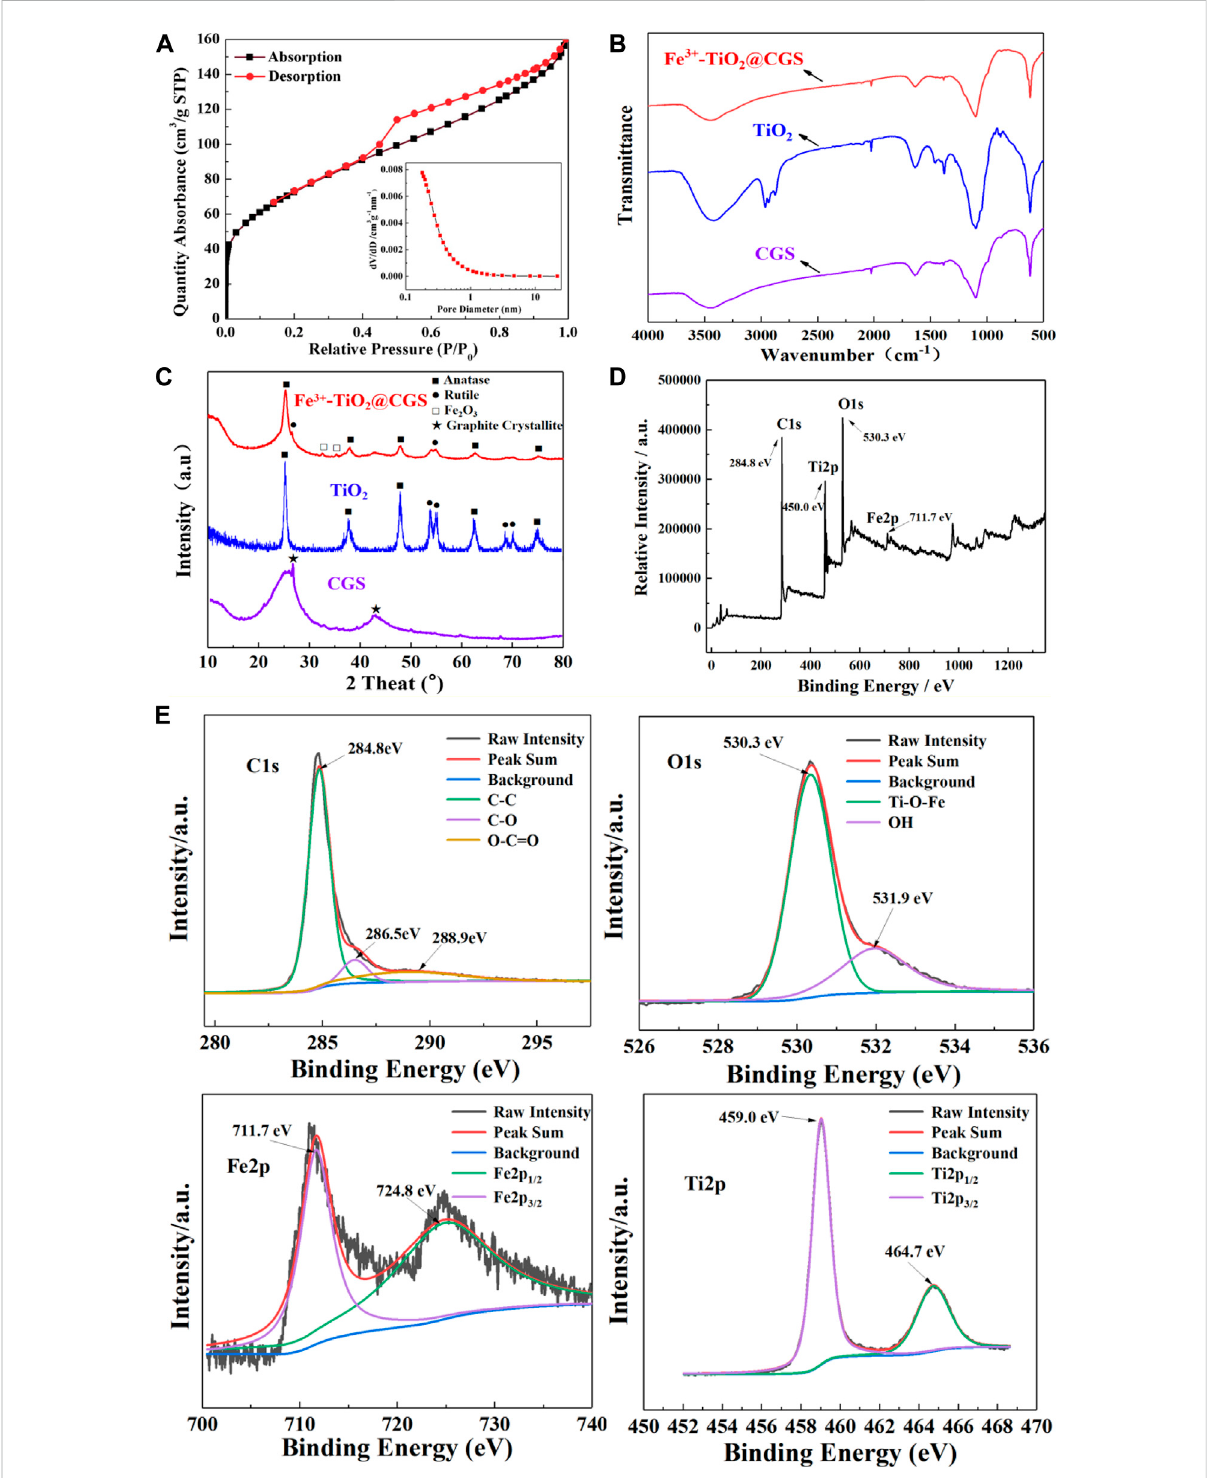
FIGURE 4 (A) AbsorptionanddesorptioncurvesofFe 3+ -TiO 2 @CGSparticles(theinsetshowstheporesizedistributioncurve); (B) FT-IRofFe 3+ -TiO 2 @CGS three-dimensional electrode; (C,D) XRD and XPS full spectra of Fe 3+ -TiO 2 @CGS three-dimensional electrode; (E) XPS spectrum (C1s, O1s, Fe2p and Ti2p) of Fe 3+ -TiO 2 @CGS three-dimensional